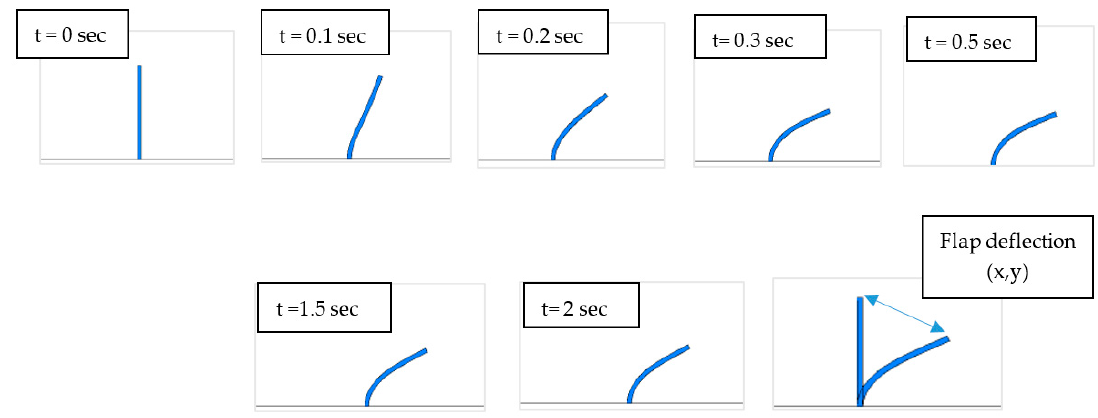
Figure 8. Flap visualization at time t, Re = 9.